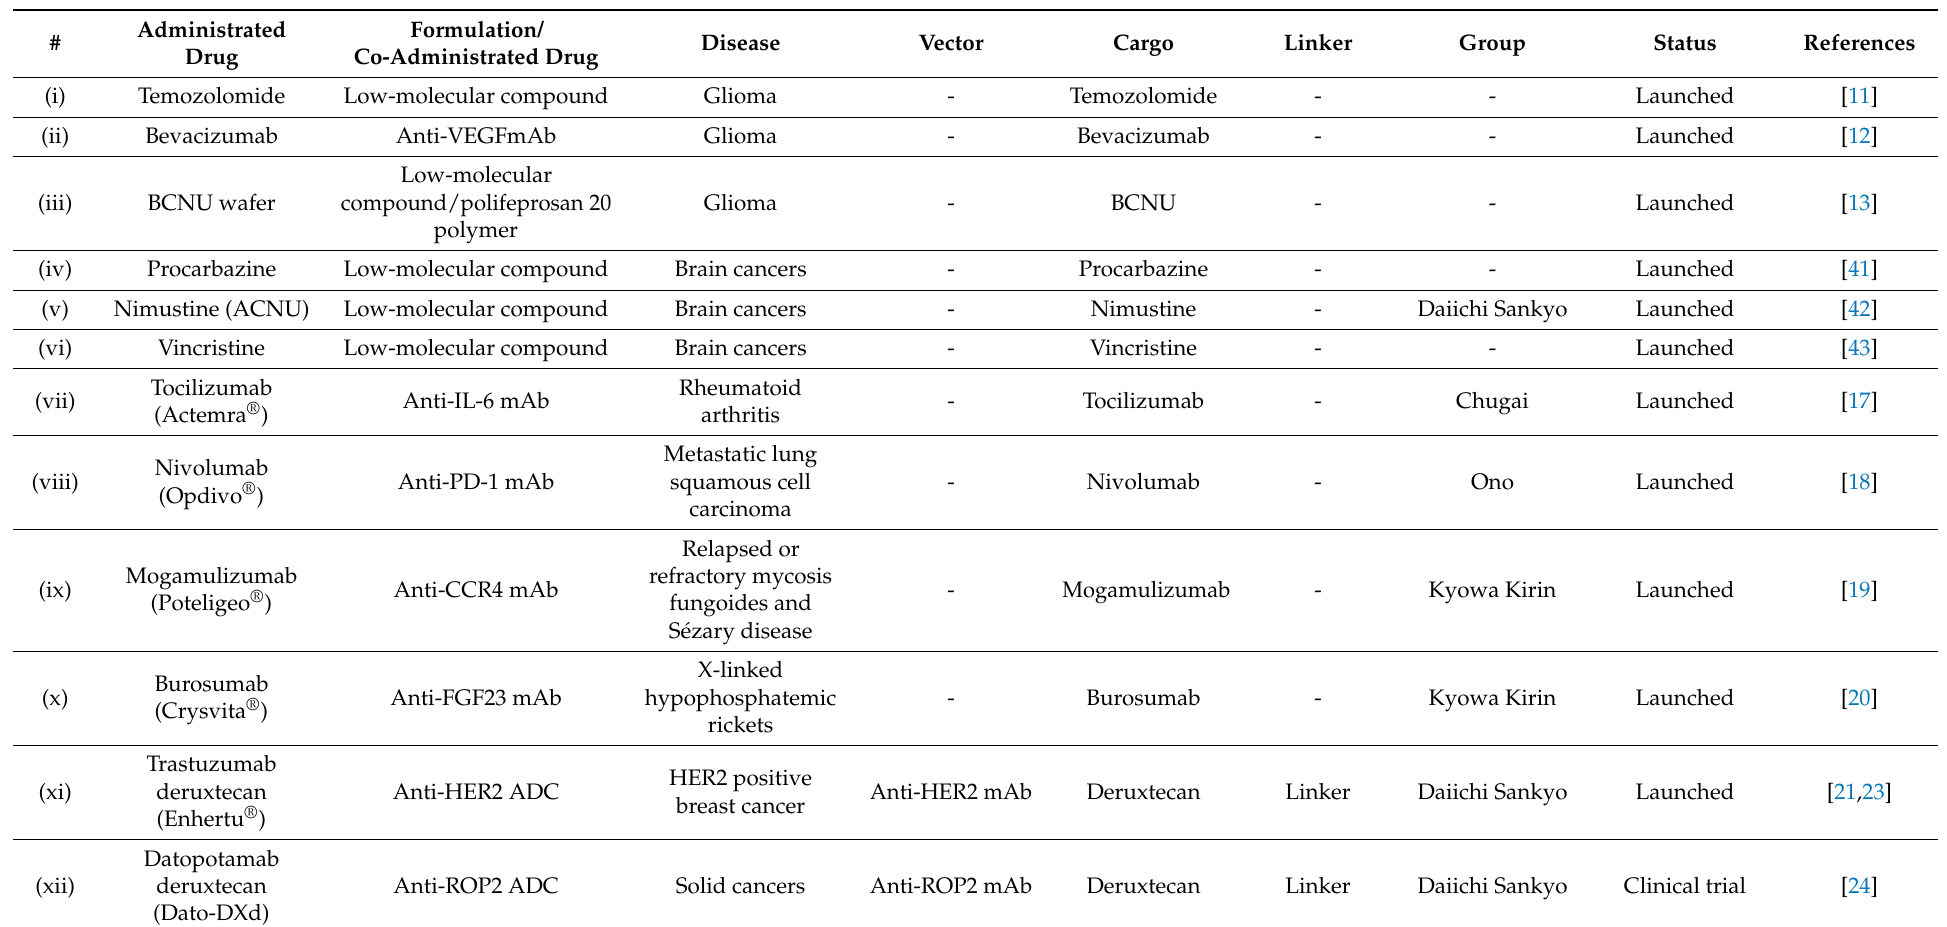
Table 1. All the compounds introduced in this perspective